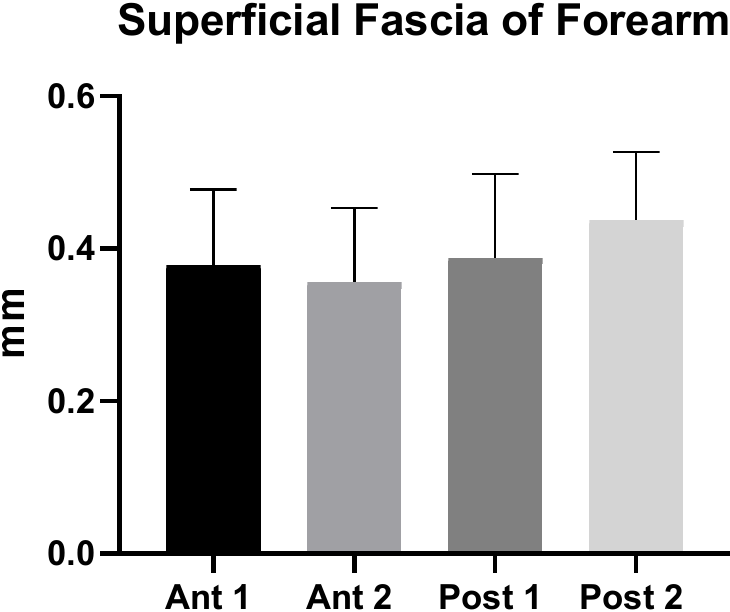
Figure 4. Ultrasound thickness measurements of the superficial fascia of the forearm. The superficial fascia had a mean thickness of 0.41 ± 0.1 mm in the posterior region compared with a mean thickness of 0.40 ± 0.10 mm in the anterior region (Table 4). More- over, no differences were found between right and left sides for all regions and levels ( p > 0.05). In addition, the comparison within different regions/levels of the superficial fascia of forearm are reported in Table 5. According to Tukey’s multiple comparison test, the comparison between superficial fascia thickness among various levels/regions of the forearm showed some statistically significant difference (Table 5). Table 5. Ultrasound measurements within different regions/levels of the superficial fascia of the forearm. Statistically significant results are showed in bold. *: p < 0.05; **: p < 0.01; ****: p < 0.0001. ns: not statistically significant.